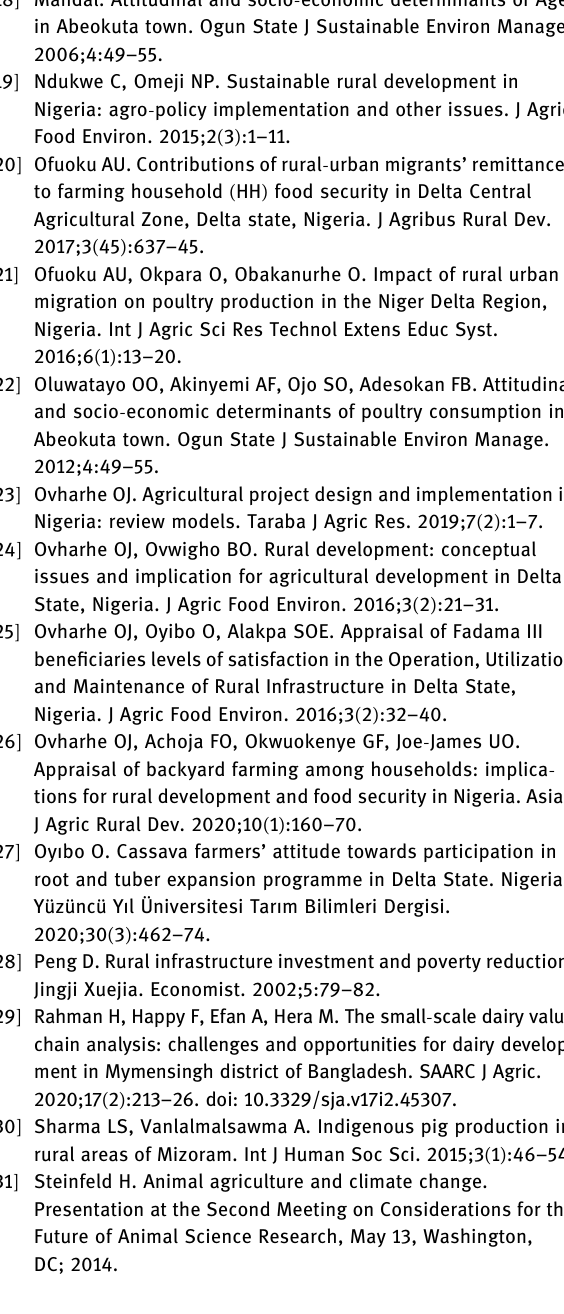
E ff ect of disease management on pro fi tability of poultry production in south west Nigeria. Asian J Poultry